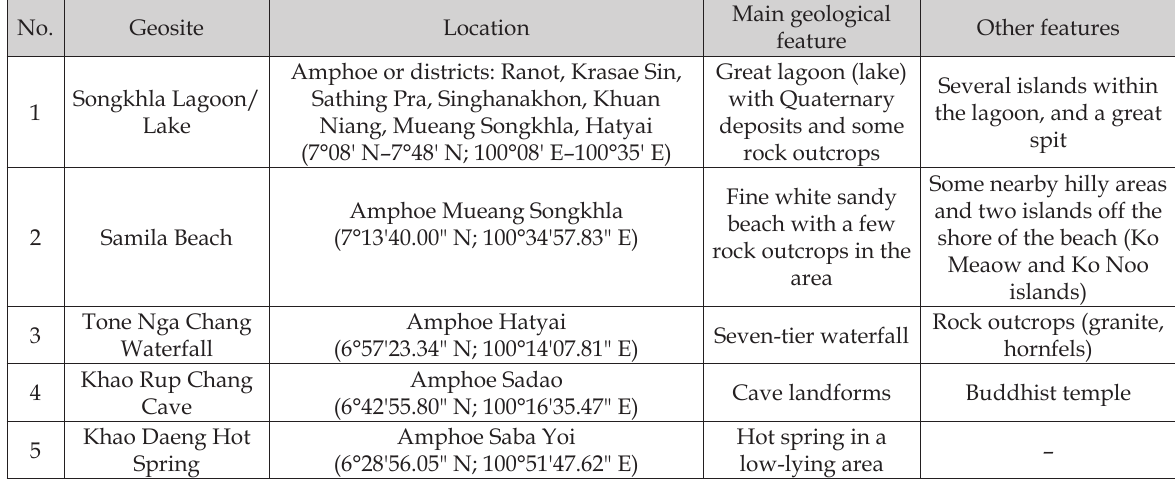
Table 1. List of selected geosites as potential geoheritage resources and geotourism attractions in Songkhla Province,